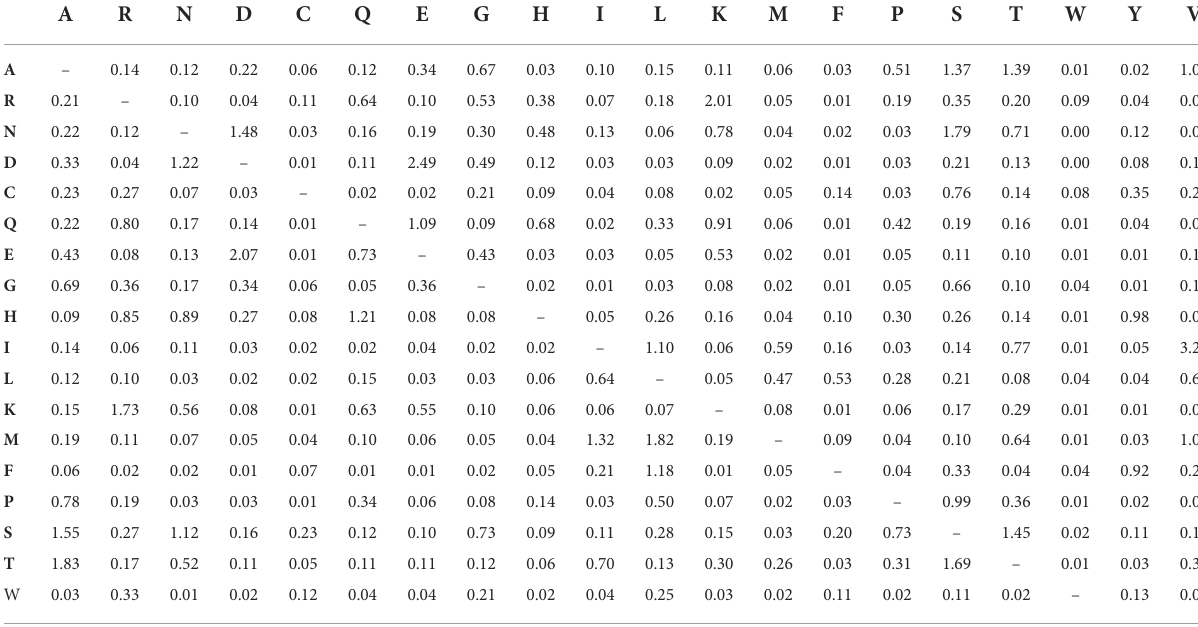
TABLE 11 Maximum likelihood estimate of substitution matrix of deduced amino acid